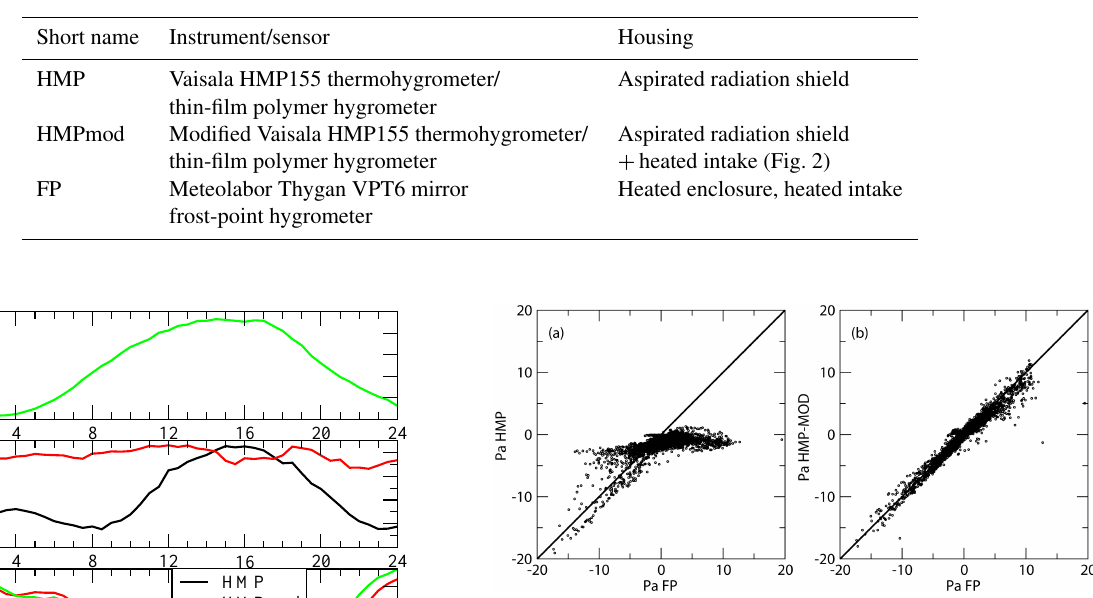
Table 1. List of hygrometers and adaptations. See text for details.